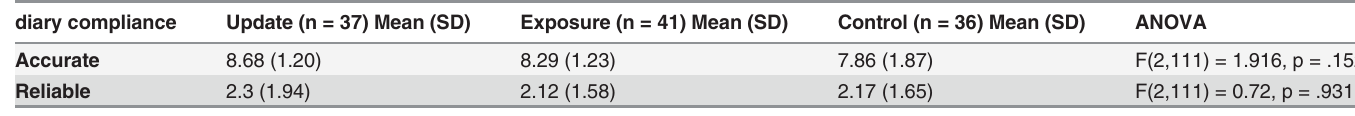
Table 4. Self-reported diary compliance at